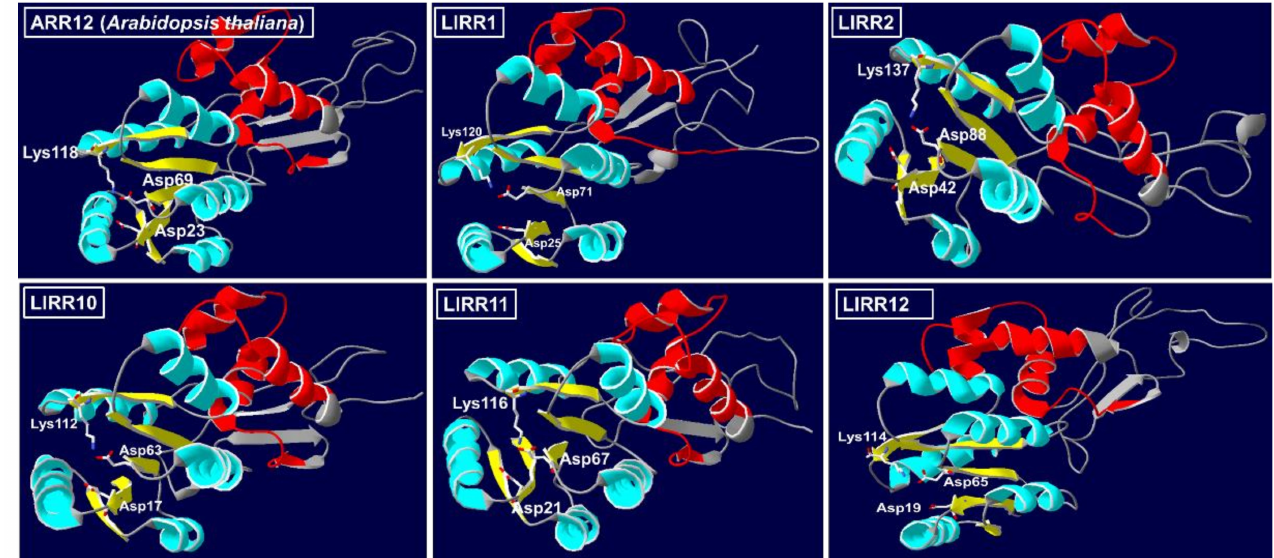
Figure 2. Predicted 3-D structure of ARR12 and five type-B LlRR proteins. The colors used in the predicted 3-D structure models indicate the different structures. Yellow indicates the five N-terminal β -sheets in the CheY-homologous receiver (REC) domain, and conserved Asp, Asp and Lys residues are located at the C-terminal ends of three β -sheets; blue indicates the five N-terminal α -helixes in the CheY-homologous receiver (REC) domain; red indicates the C-terminal Myb DNA-binding (MYB)